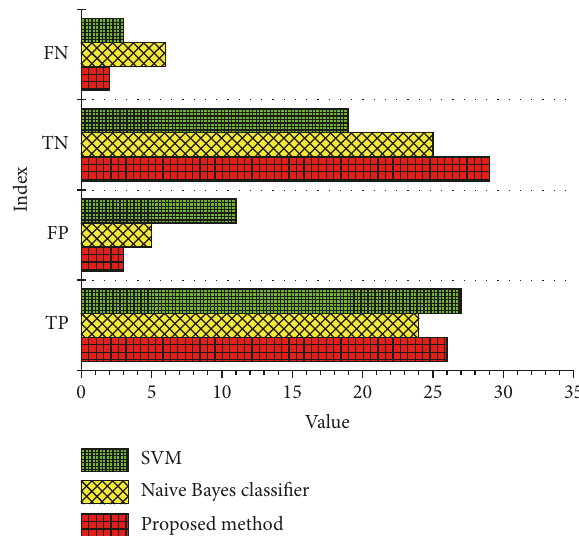
Figure 8: Outcomes of classification of different methods.